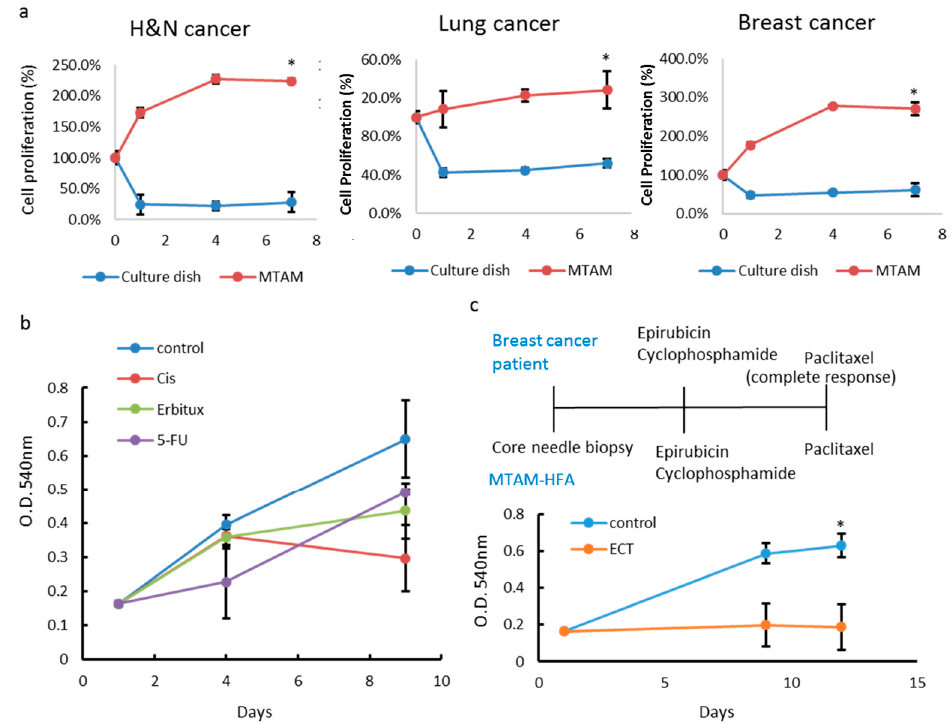
Figure 5. PDTC models accurately replicate patient responses. ( a ) Graph depicting different tumor types growth in culture dish or MTAM to establish PDTC. ( b ) PDTC colon cancer models were screened by different type of anticancer drugs. ( c ) PDTC models were screened against the corresponding therapies received by the patient. Graphs show the average implanted cell viability for three to nine animals and SD. * Treated groups significantly different from untreated controls at the end point of the experiment (Student’s t-test; P < 0.05).